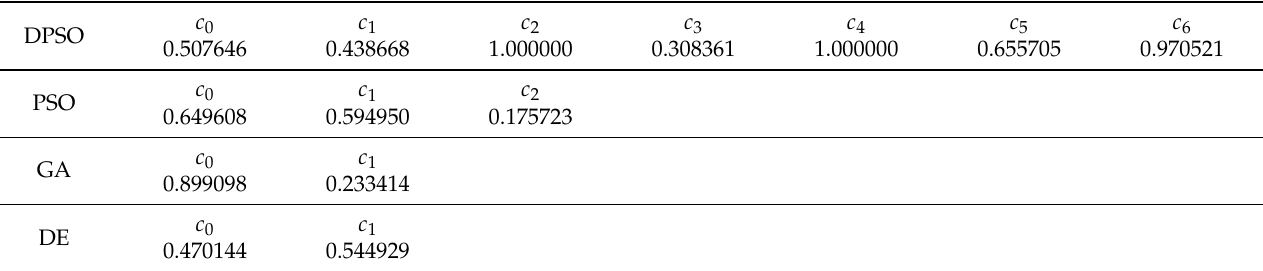
Table A2. Global best self-tuning parameters for 14 dimensions.